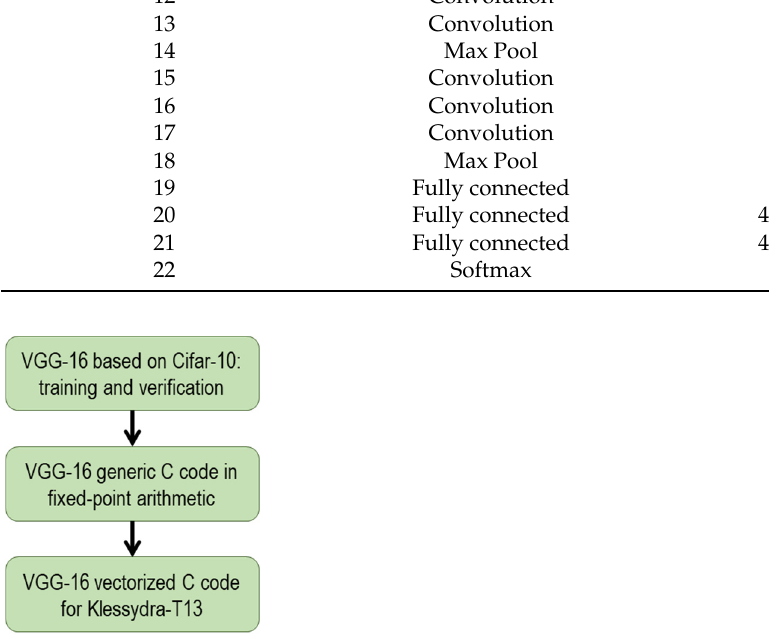
Figure 6. Workflow for the VGG-16 implementation. Table 3. Cifar-10 VGG-16 inference layers.